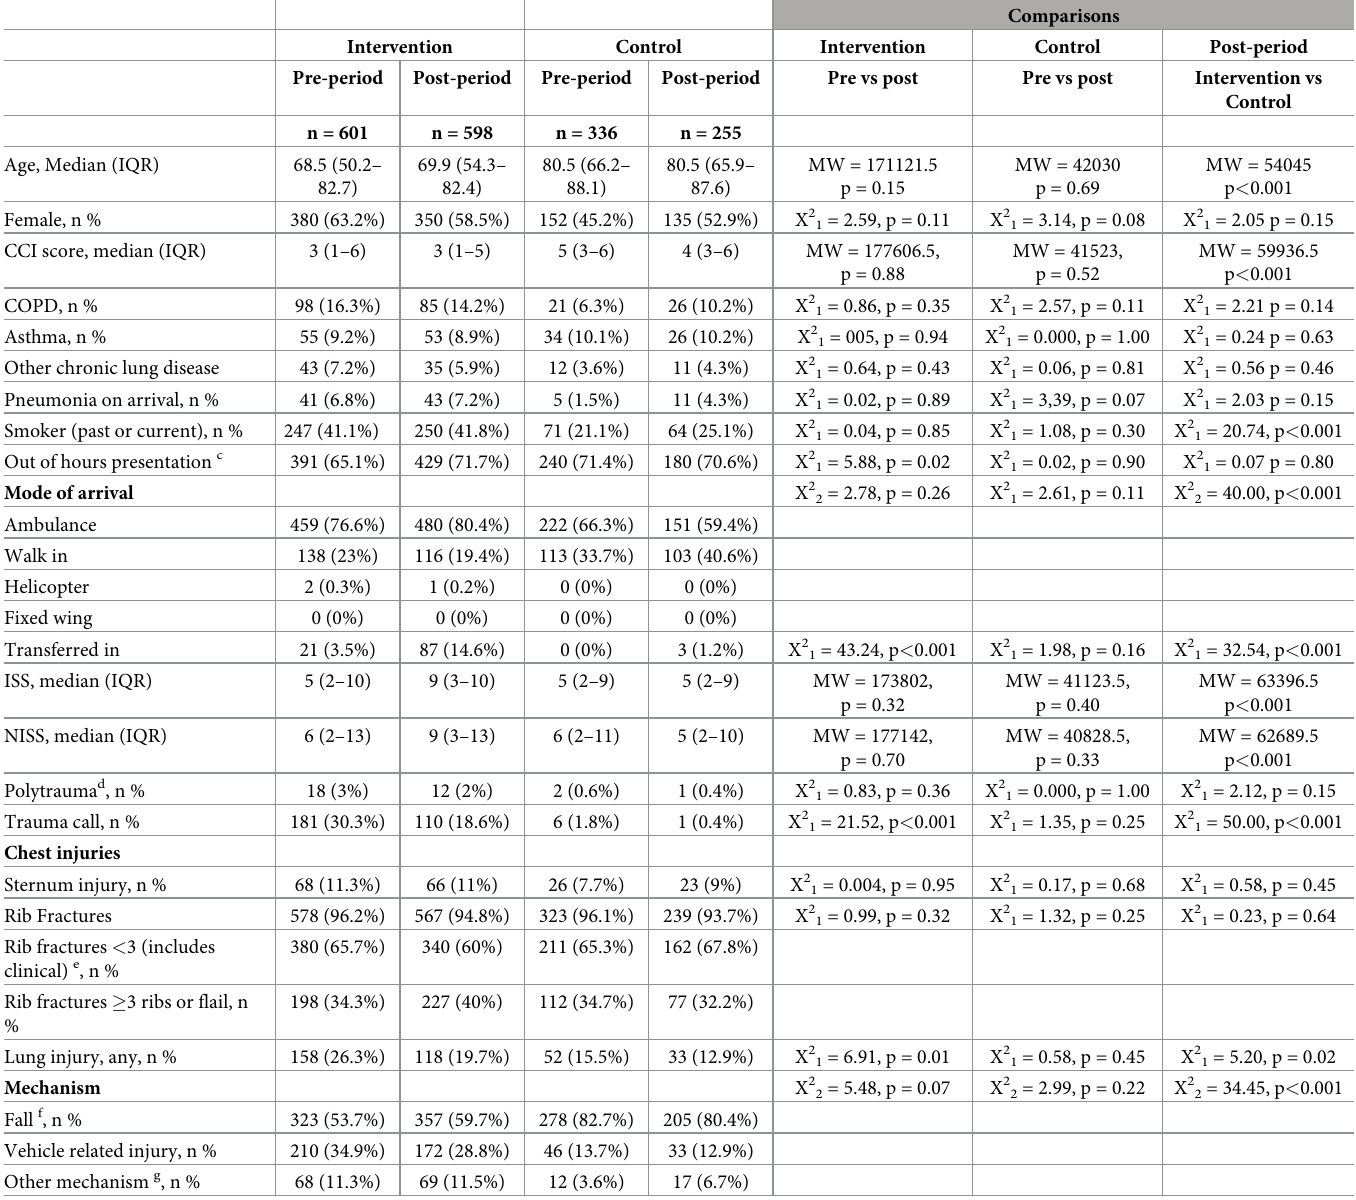
Table 1. Patient characteristics intervention vs control (overall study period) (N =